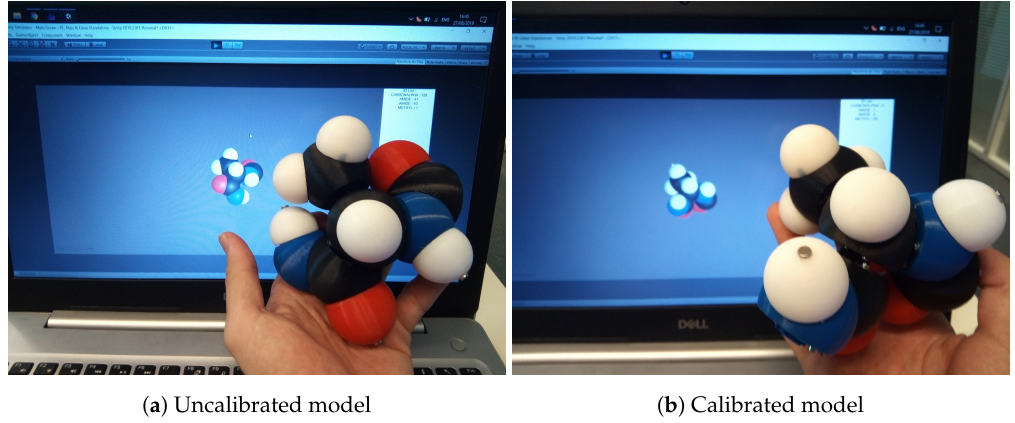
Figure 19. Offset representations in the